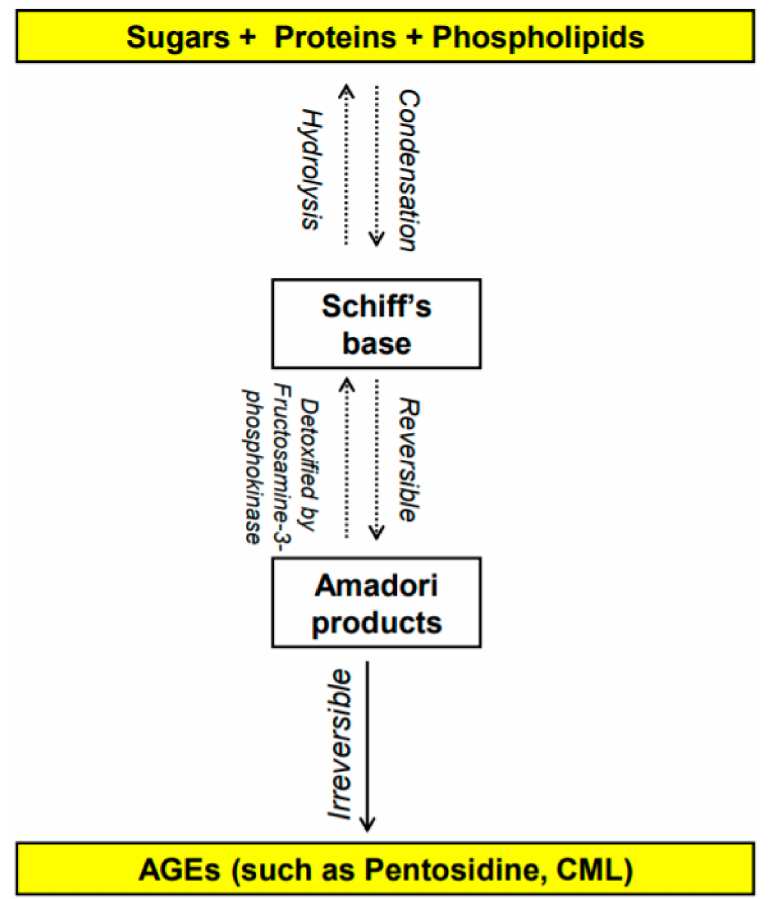
Figure 1. Overview of the formation of advanced glycation end products (AGEs) [1–6]. N-carboxymethyl- lysine